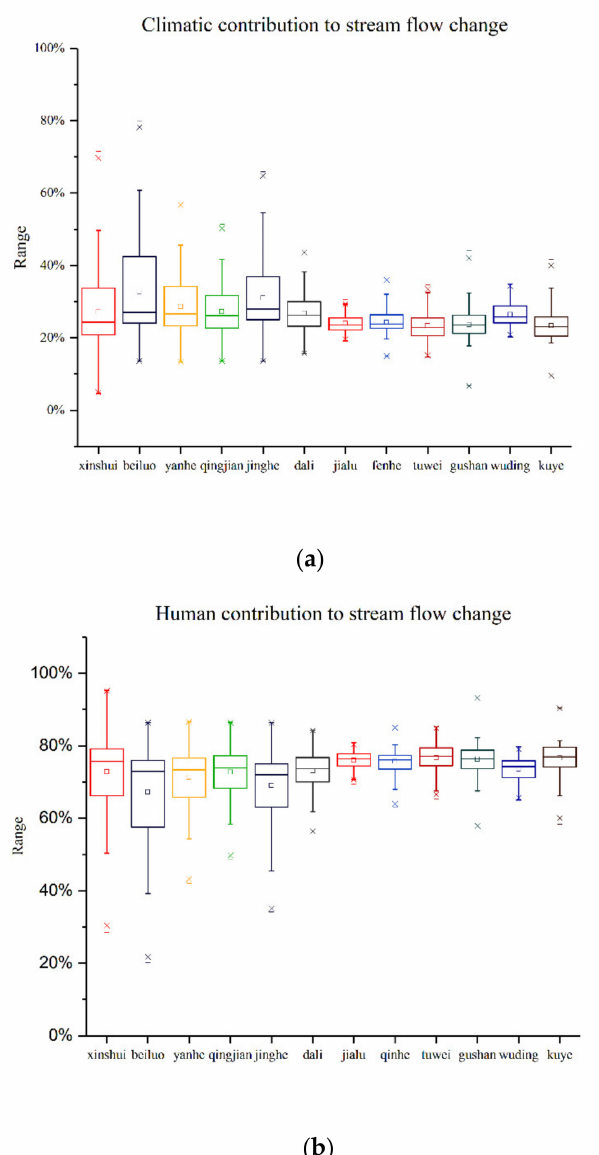
Figure 2. Boxplots made by all contribution data: ( a ) the variability of climatic contribution to streamflow change; ( b ) the variability of human contribution to streamflow